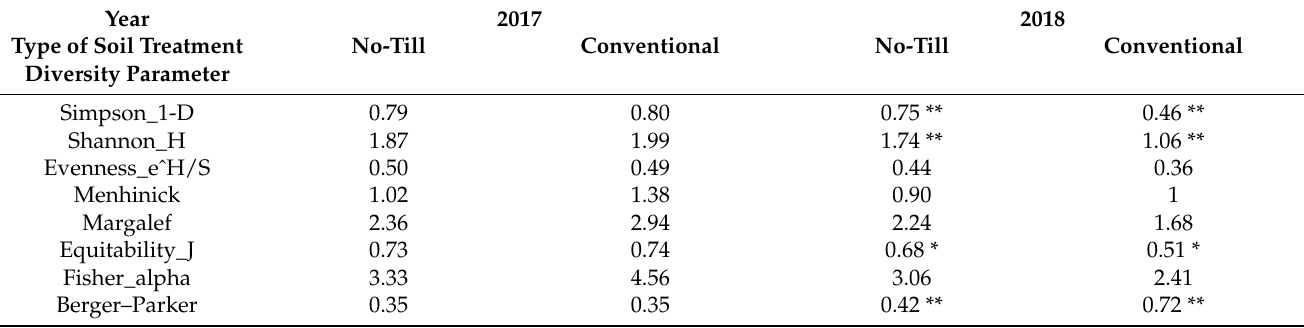
Table 2. General indicators of taxonomic diversity of invertebrate communities depending on the type of tillage (conventional or no-till). Significant differences (permutation test) are given with asterisks. *— p < 0.05, **— p <